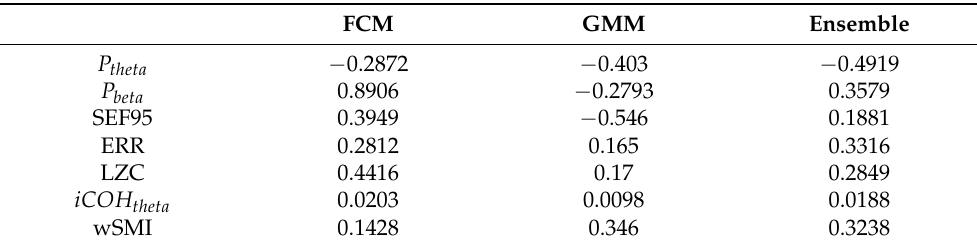
Table 2. Spearman correlation coefficients between all features and estimated levels of consciousness. All correlation coefficients have p -value p ≤ 0.05.